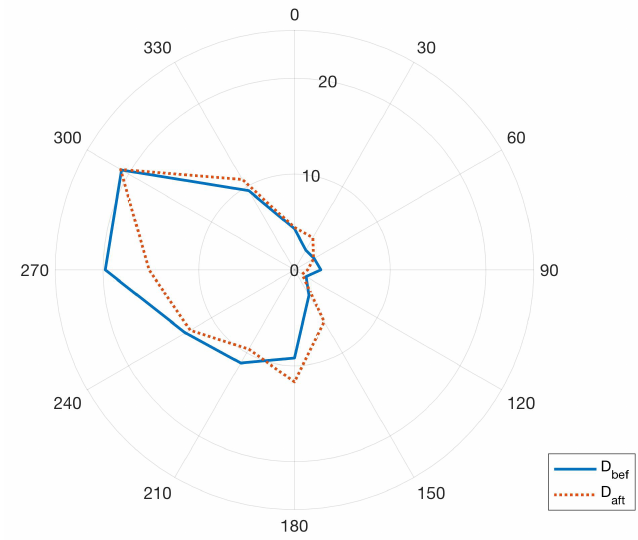
Figure 2. The wind direction roses at T1 during D bef and D aft .